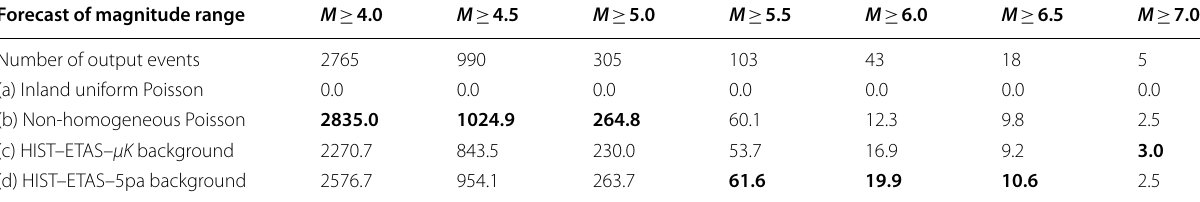
Scores are the same as explained in Table 2